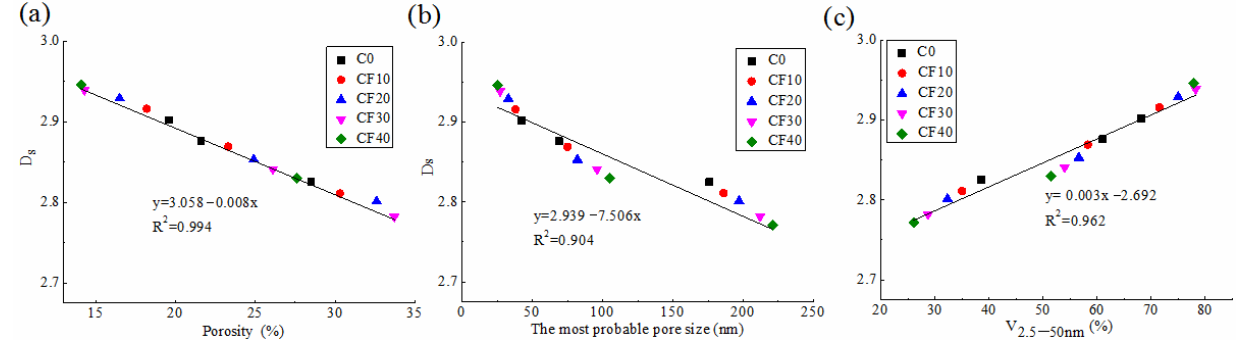
Figure 7. Correlation between D s and ( a ) porosity, ( b ) the most probable pore size and ( c ) V 2.5–50nm. As shown in Figure 7, the porosity, the most probable pore size and V 2.5–50nm of face Table 6. V 2.5–50nm of face slab concrete added with different fly ash slab concretes were closely related with D s , with high R 2 values of 0.994, 0.904 and 0.962, respectively, demonstrating that the pore structure parameters can be characterized and represented by D s . This result corresponds well with other studies [30,31,71]. As Jin et al.